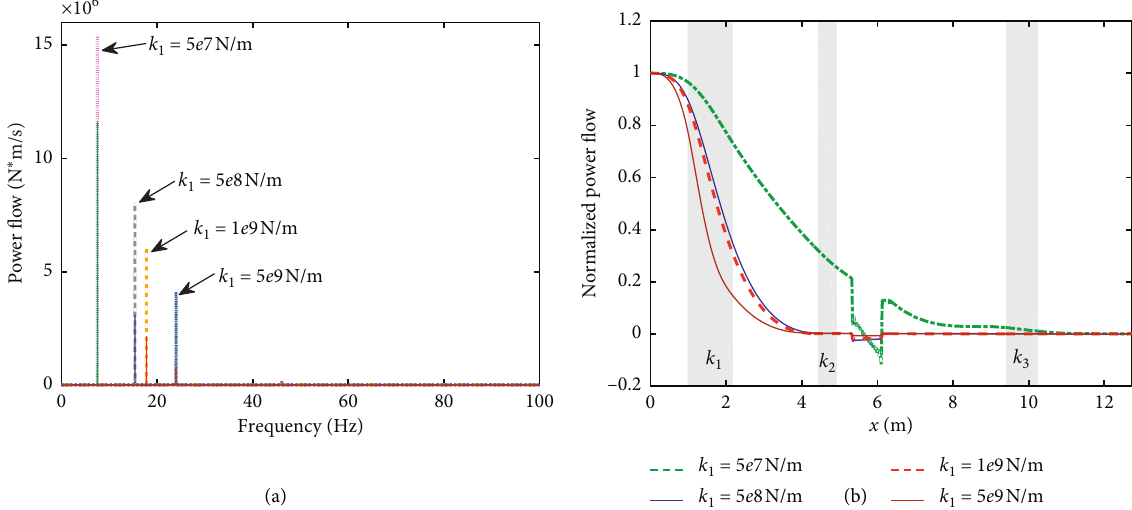
Figure 8: Power flow analysis of the propulsion system with different stiffnesses of stern rear bearing. (a) Power flow through bearing; (b) power flow distribution across the whole